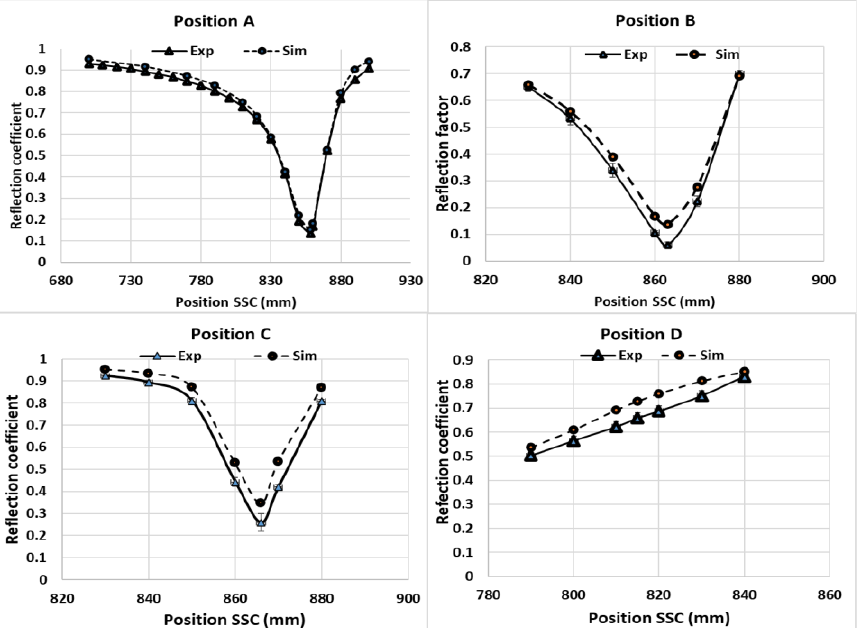
Figure 6. Reflection coefficients of Tylose ® at positions A, B, C, and D following various SSC positions.